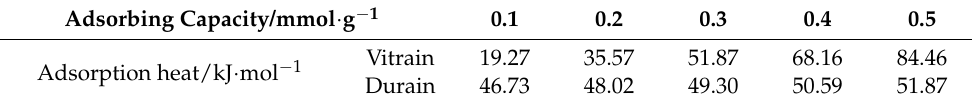
Figure 10. The relationship between heat of adsorption and adsorption capacity in the desorption process.